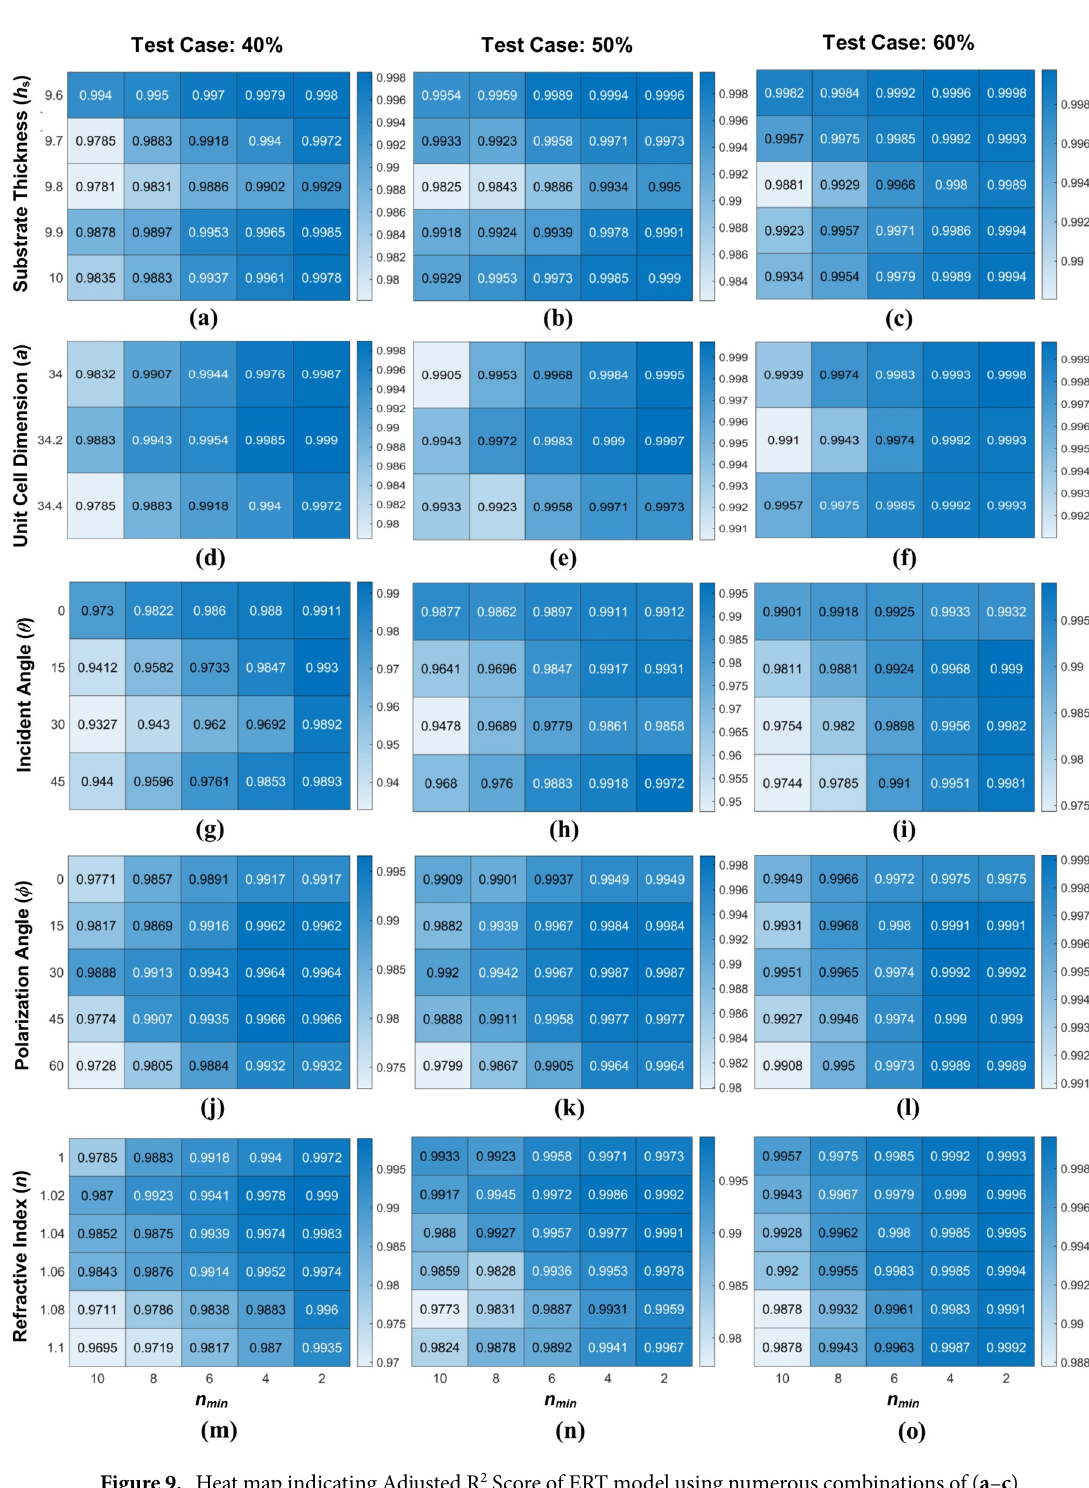
Figure 9. Heat map indicating Adjusted R 2 Score of ERT model using numerous combinations of ( a – c ) substrate thickness, ( d – f ) unit cell dimension, ( g – i ) incident angle, ( j – l ) polarization angle and ( m – o ) refractive index for different test case 40%, 50%, and 60%. Images were produced using MATLAB (R2022b, https:// www. mathw orks.